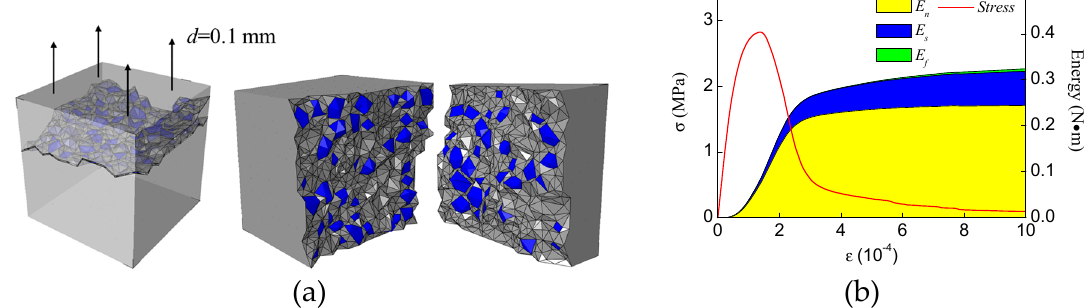
Figure 18. Fracture pattern and energy evolution of the concrete specimen under uniaxial tension: ( a ) fracture pattern and main fracture surfaces, ( b ) energy evolution.